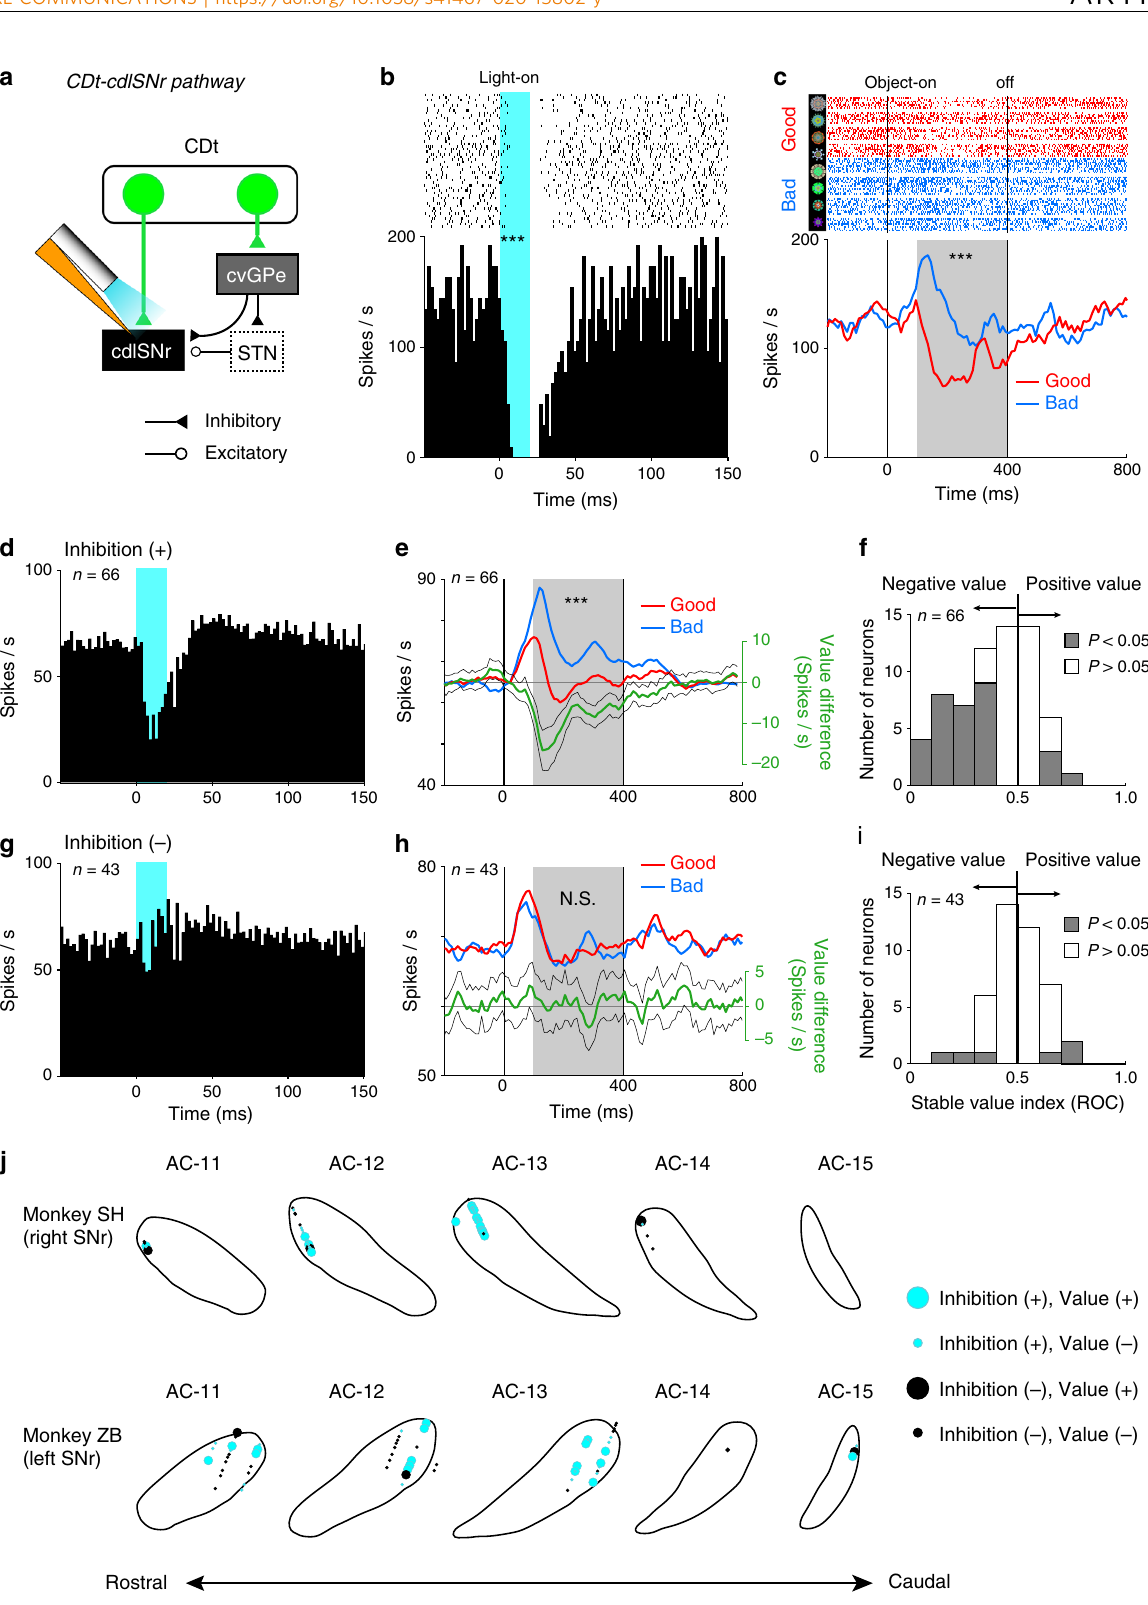
started with an early excitation (latency: ~ 50 ms), but was not followed by differential responses to good and bad objects (Fig. 4h, P = 0.52, Wilcoxon signed-rank test). As individual neurons, only three neurons encoded stable values (Fig. 4i). The 17 Inhibition ( − ) neurons were located both in cvGPe (black circles in Fig. 4j) and also outside